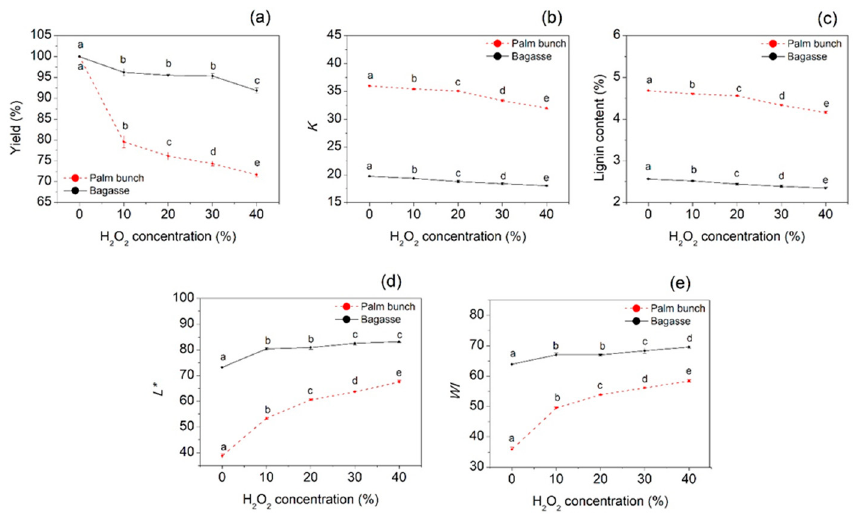
Figure 1. ( a ) Yield, ( b ) Kappa number, ( c ) lignin content and color values, ( d ) L* , and ( e ) WI of cellulose from palm bunch and bagasse. Abbreviations: L* , lightness; WI, whiteness index.